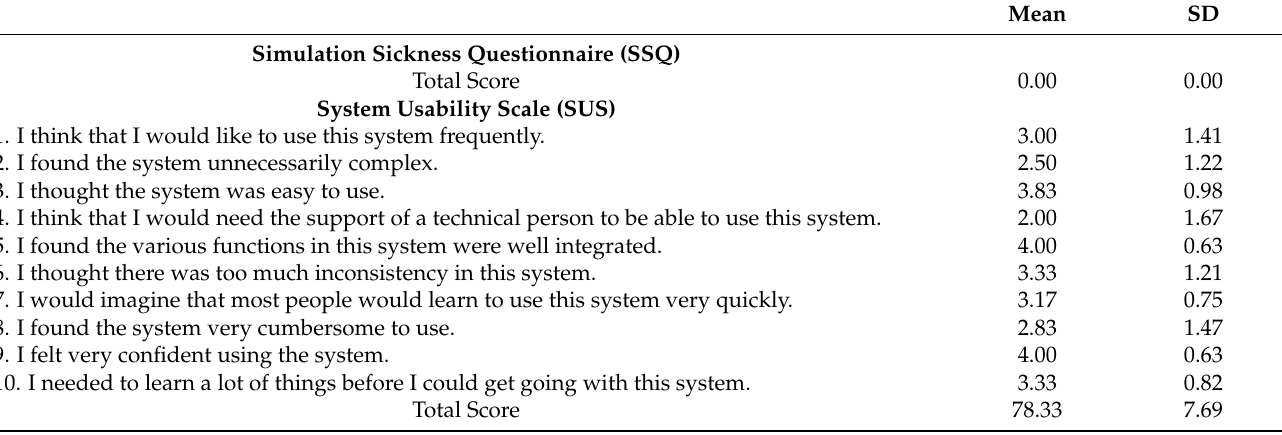
Table 3. Cybersickness and usability in the experimental